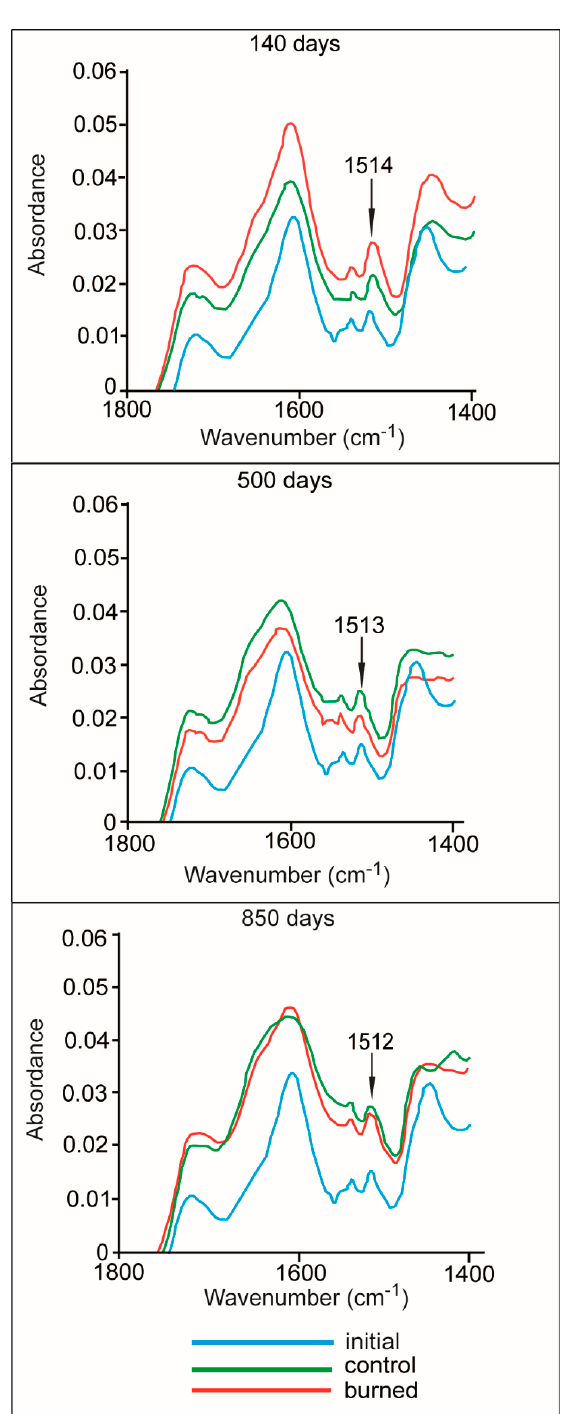
Figure 5. Fourier transformed infrared spectrum of needle litter at di ff erent stages of decomposition. Each line represents the arithmetic mean of spectra ( n =